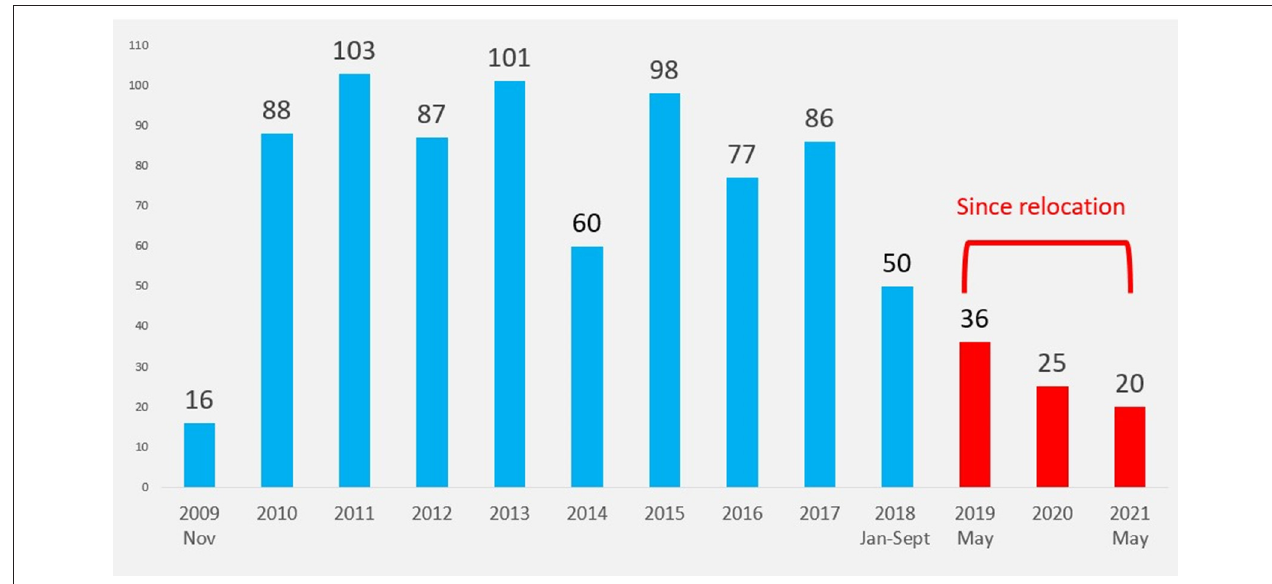
FIGURE 1 | Surgical activities at the Shisong Cardiac Centre since 2019 (before and after relocation). The y-axis represents the number of cardiac surgeries.